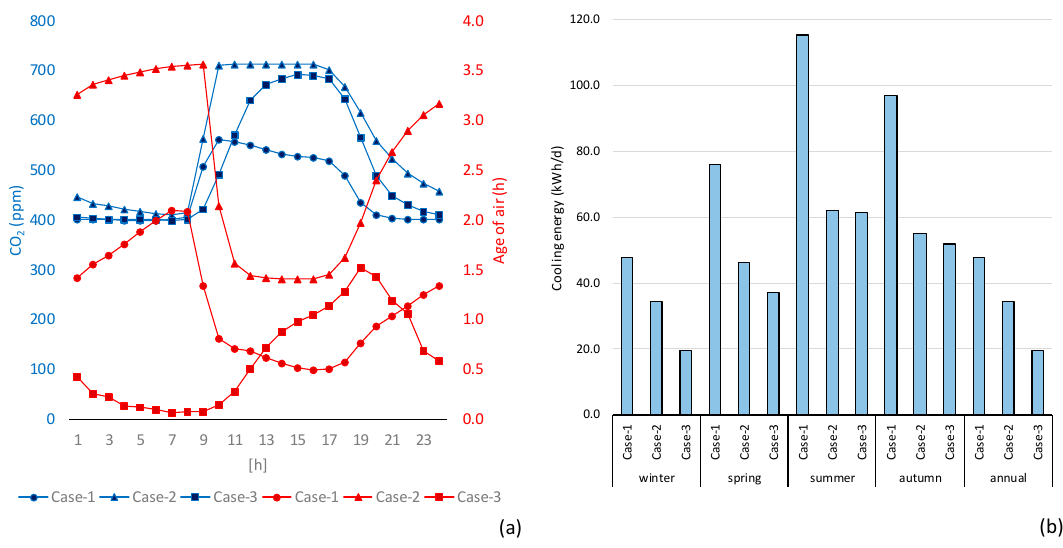
Figure 8. Projection of average monthly indoor temperature in relation to outdoor temperature under hybrid ventilation in Case-3.